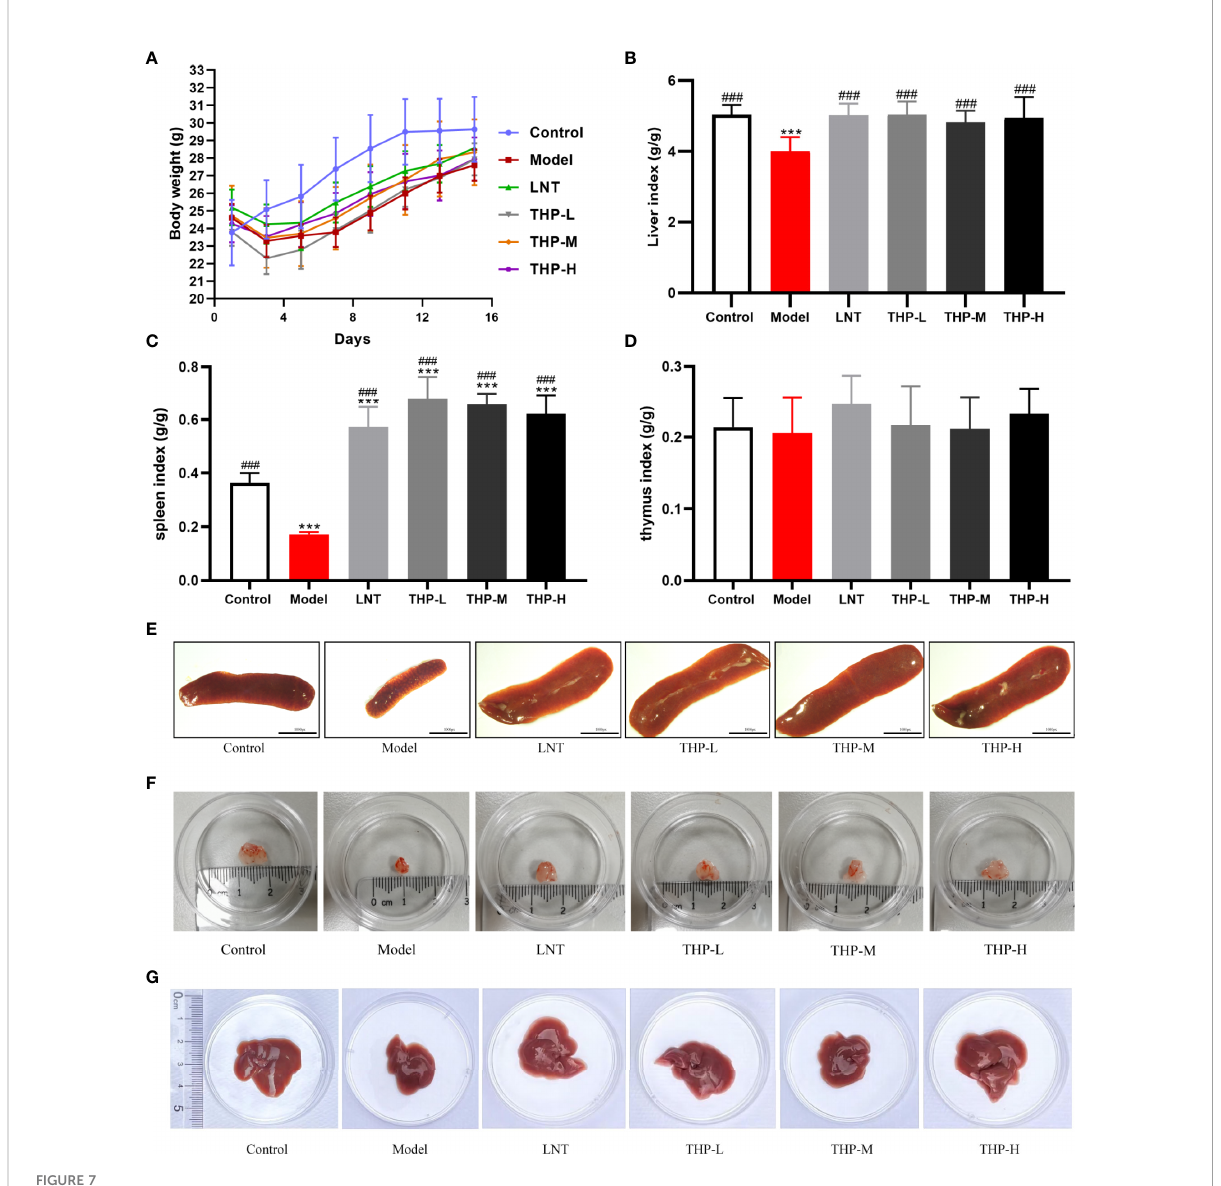
FIGURE 7 Effect of THP on the body weight and organ index. (A) Effect of THP on body weight. (B) Effect of THP on Liver index. (C) Effect of THP on the spleen index. (D) Effect of THP on the thymus index. (E) Effect of THP on the spleen. (F) Effect of THP on the thymus. (G) Effect of THP on the liver. Each value is presented as the mean±SD. ***P<0.001 versus Control; ### P<0.001 versus